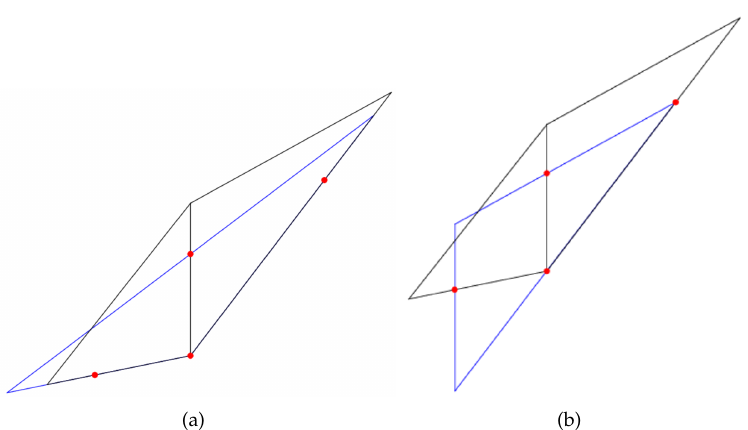
Figure 10. PS6 triangles associated with a near degenerate vertex obtained by quadratic programming ( a ) and the proposed algorithm ( b ). The area of the triangle provided by the Dierckx’s method was equal to 0.2344 cm 2 and the diameter was equal to 12.7857 cm. The area and the diameter of the second one were 0.25 cm 2 and 7.9907 cm, respectively.